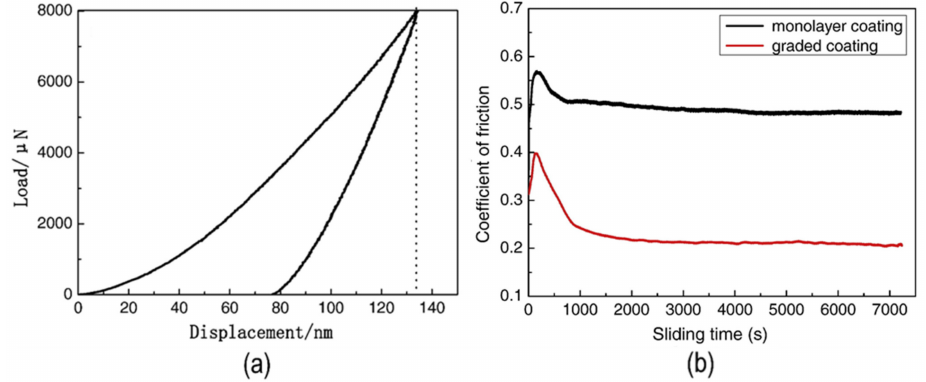
Figure 5. ( a ) Load-displacement response of graded coating ( b ) COF vs. sliding time response. Reprinted with permission from